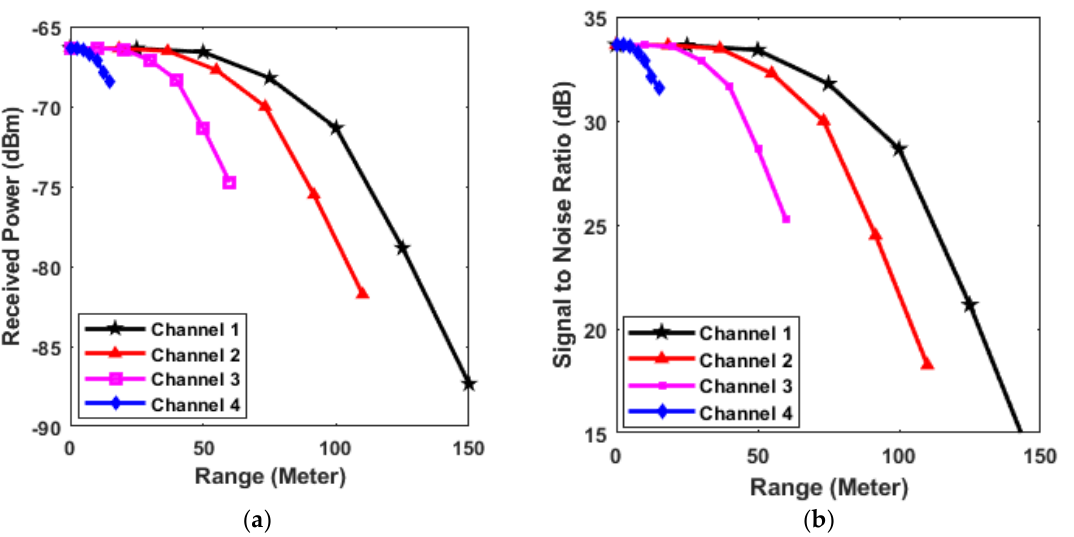
Figure 5. ( a ) Received power and ( b ) signal-to-noise ratio (SNR) with respect to range at 1 GHz bandwidth.